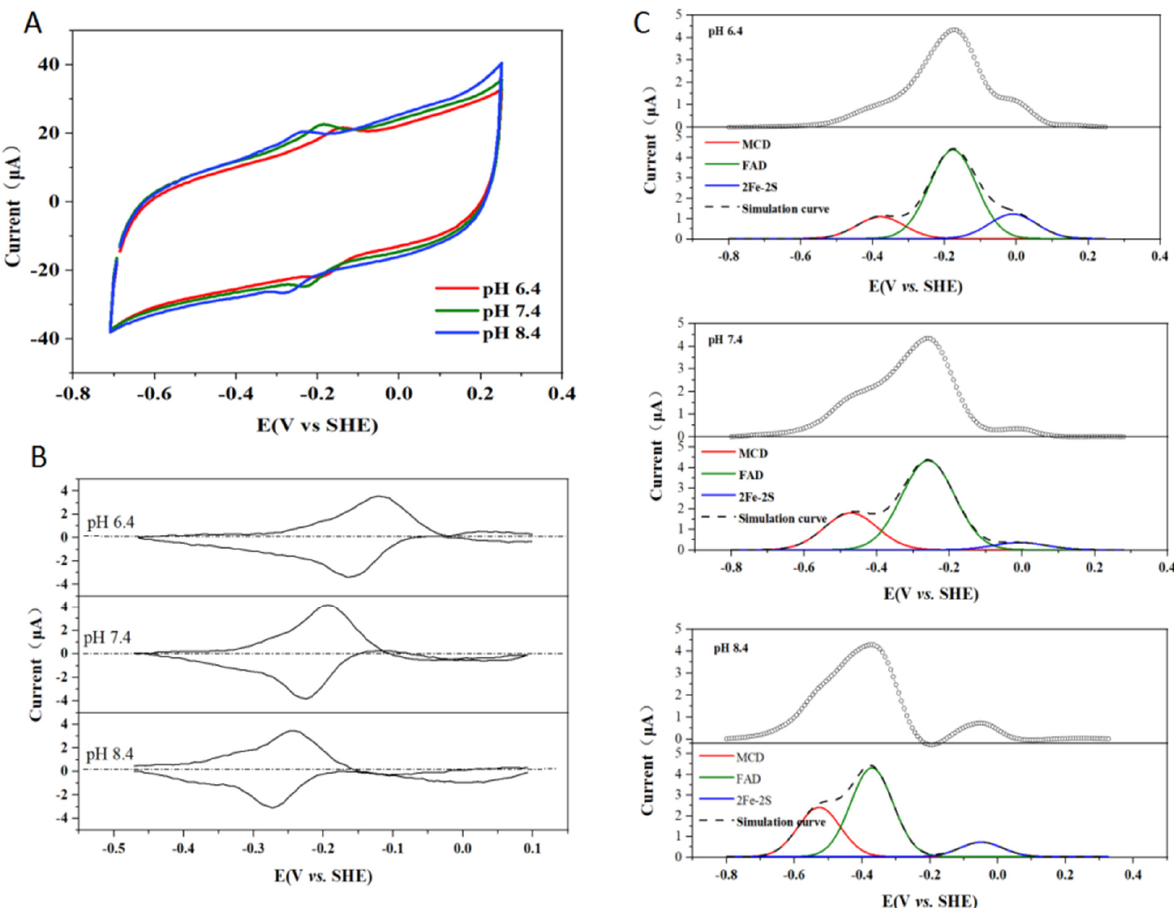
Figure 7. Cyclic voltammogram of Kdh. ( A ) Cyclic voltammogram of Kdh (0.1 mg/mL) in 10 mM Tris buffer with 0.9% NaCl at various pH. The voltammetric rate was 0.5 V·s − 1 and the temperature was 25 °C. ( B ) Voltammograms of Kdh at a PGE electrode (with an area of 0.04 cm 2 ) in the absence of 6-HPON, corrected for non-faradaic background current. The scan rate was 0.5 V·s − 1 (analogue mode), and the temperature was 25 °C. The electrolyte consisted of 0.1 mg/mL bulk Kdh in 10 mM Tris buffer containing 0.9% NaCl. ( C ) Deconvolution of the oxidation current, corrected for non-faradaic background current, at pH 6.4, pH 7.4, and pH 8.4. Other conditions are as in ( B ).